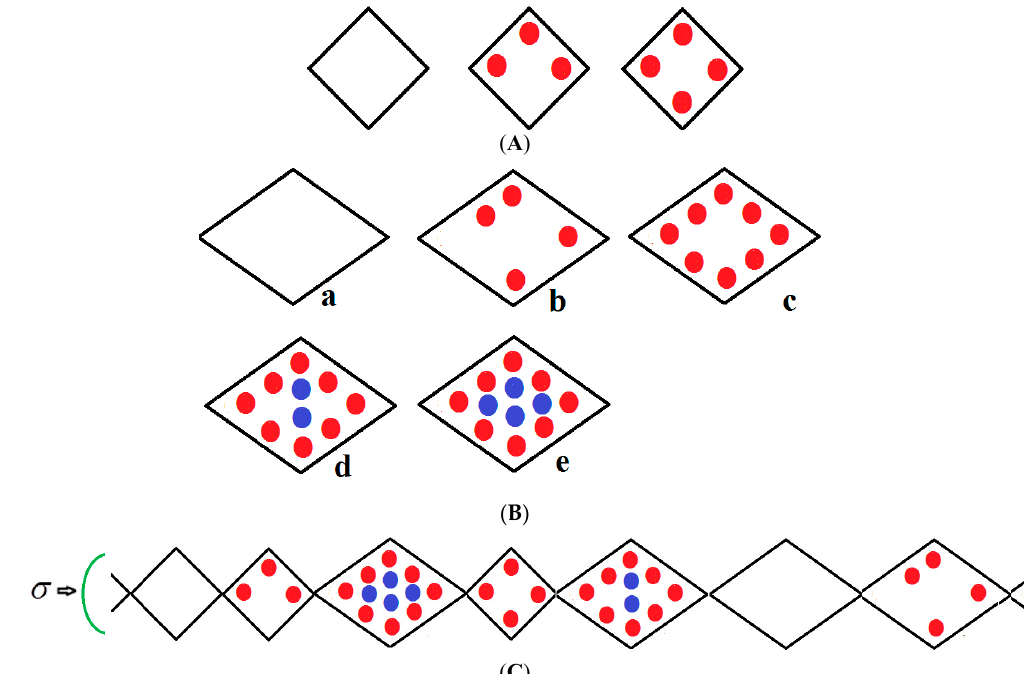
Figure 1. ( A ) Vacant, partially filled and full narrow pore; ( B ) Large pore, (a) vacant, (b) partially filled first layer, (c) filled first layer, (d) filled first layer and partially filled second layer (e), fully filled large pore.; ( C ) An example of a typical arrangement of a cluster of molecules considered in the pseudo ‐ one ‐ dimensional chain.